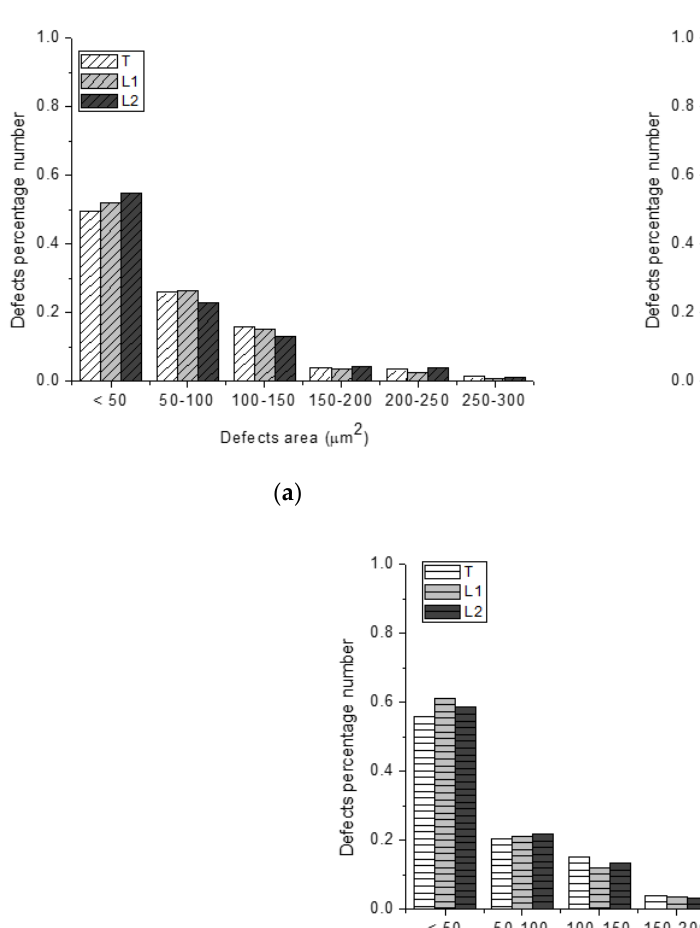
( b ) Figure 7. Optical micrographs of the T section of the D d1 sample showing ( a ) unmelted powders in the etched section and ( b ) unmelted powder associated with the void in the as polished T section. Figure 8 shows the distribution of the defect numbers according to the defect area. The highest number of defects (about 60%) occurred in the defects with an area less than 50 µm 2 . Defects with areas between 50–150 µm 2 represented 30%. The occurrence of de-